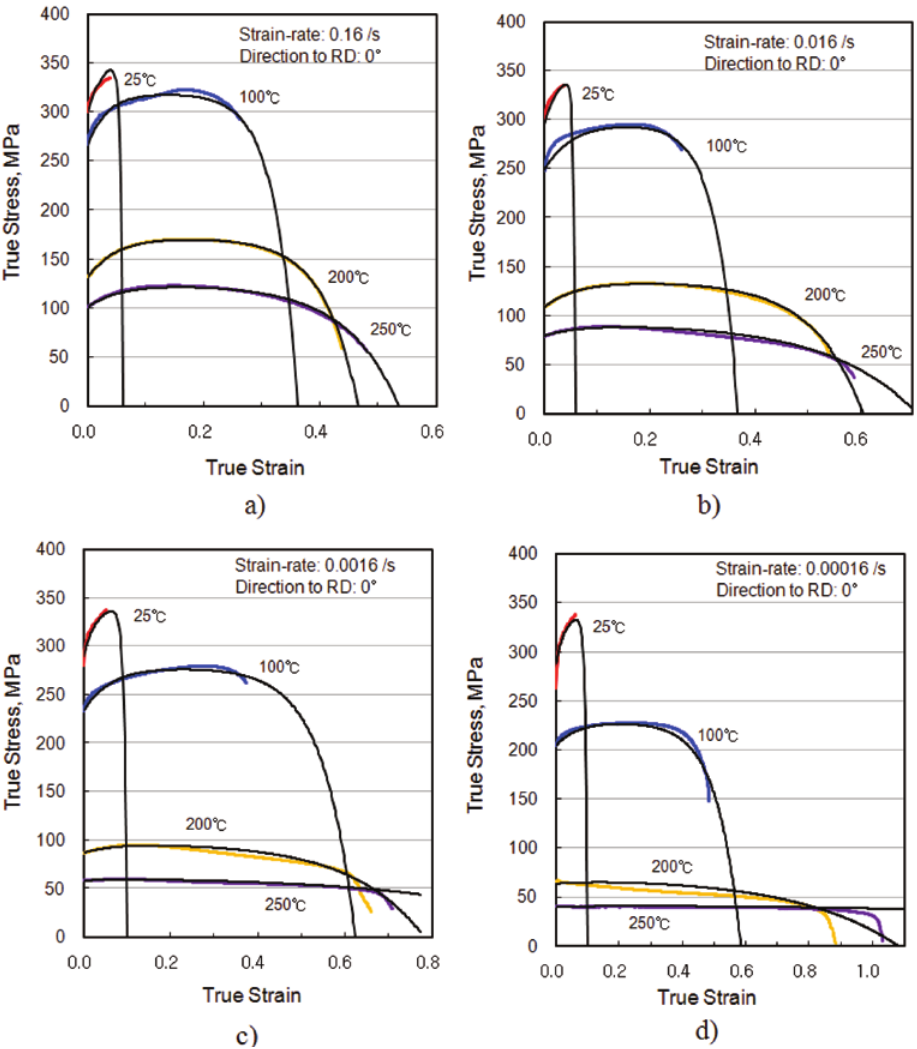
Fig. 3: Comparison between the fitting curves of Voce’s merging law and those measured by experimental test at elevated temperatures and strain rates: (a) 0.16/s, (b) 0.016/s, (c) 0.0016/s, (d)